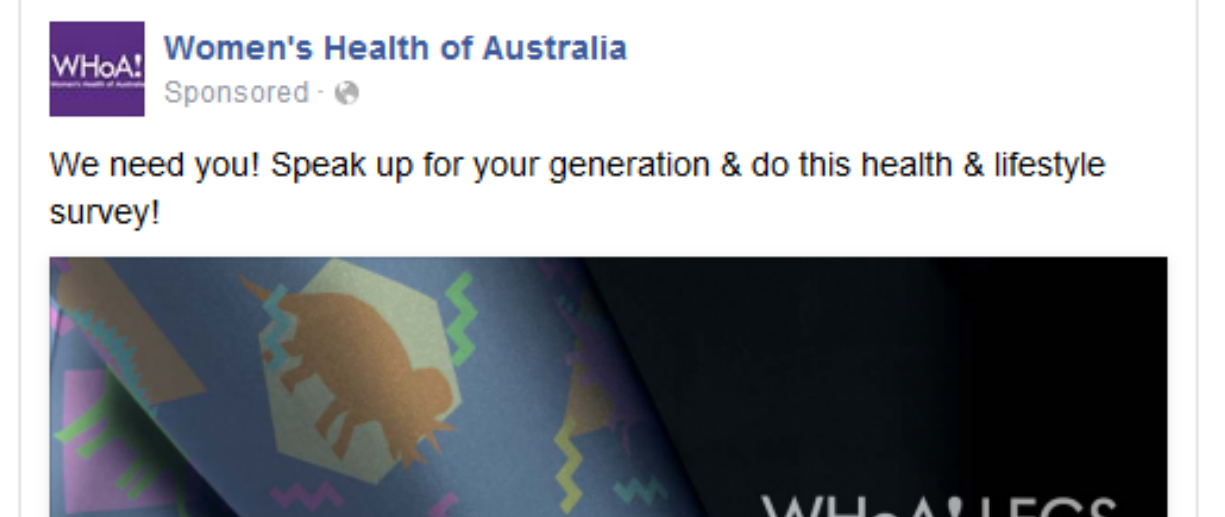
Figure 2. A less successful Facebook advertisement created as part of the WHoA! promotion, targeted at women aged 18-23 living within 16 kilometres of Henley Beach South Australia (0 users clicked the